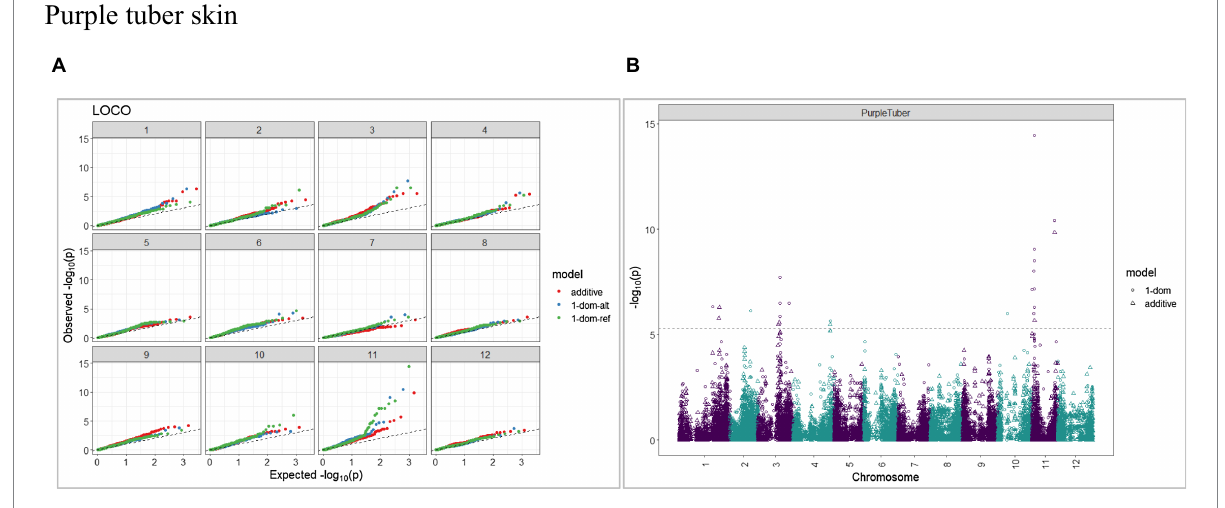
FIGURE 10 Q–Q plots of observed vs. expected -log10 ( p values) ( A ) and corresponding Manhattan plot (B) for purple skin color using the additive and dominant model for tuber traits of 214 potato clones evaluated in three environments in Texas: Dalhart 2019, 2020 and Springlake 2020. The Bonferroni threshold was at 5.3 for the additive, 5.0 for 1-dom-alt, and 5.1 for the 1-dom-ref